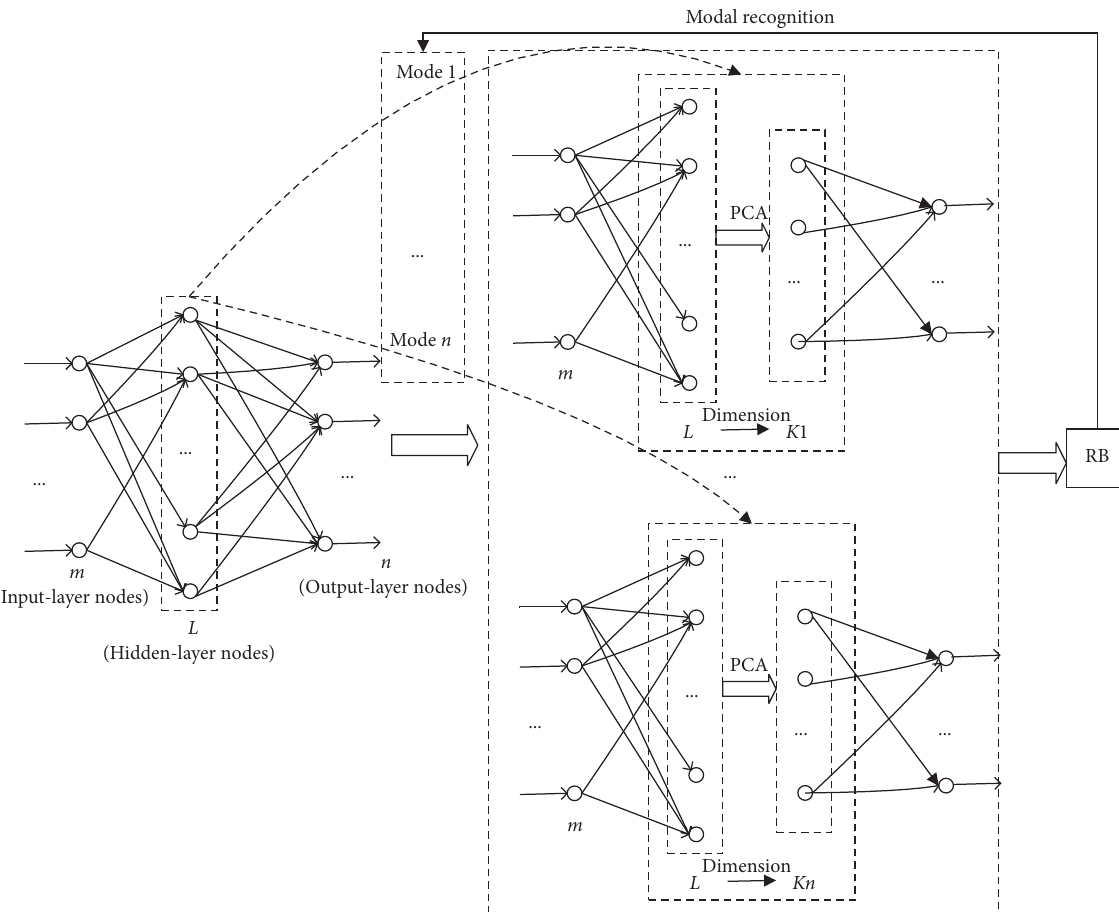
Figure 4: The diagram of a multimodal neural